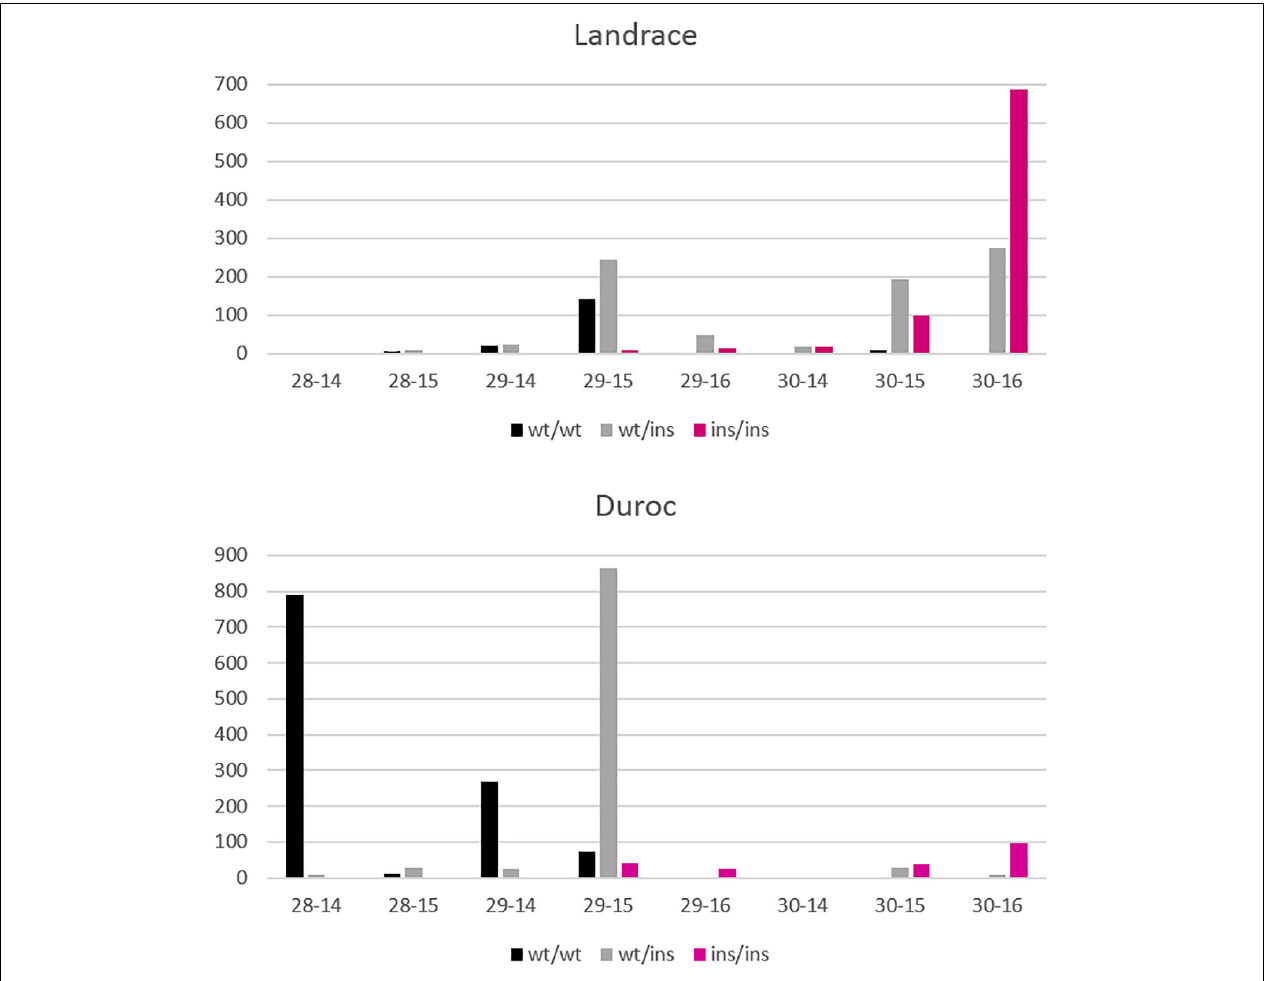
FIGURE 8 | Distribution of NVE and RIB for Landrace and Duroc animals according to their genotypes wt/wt, wt/ins, and ins/ins at the VRTN gene. Number of animals is displayed on the y axis whereas number of vertebrae-ribs are on the x axis. A few animals with extreme phenotypes were discarded for better